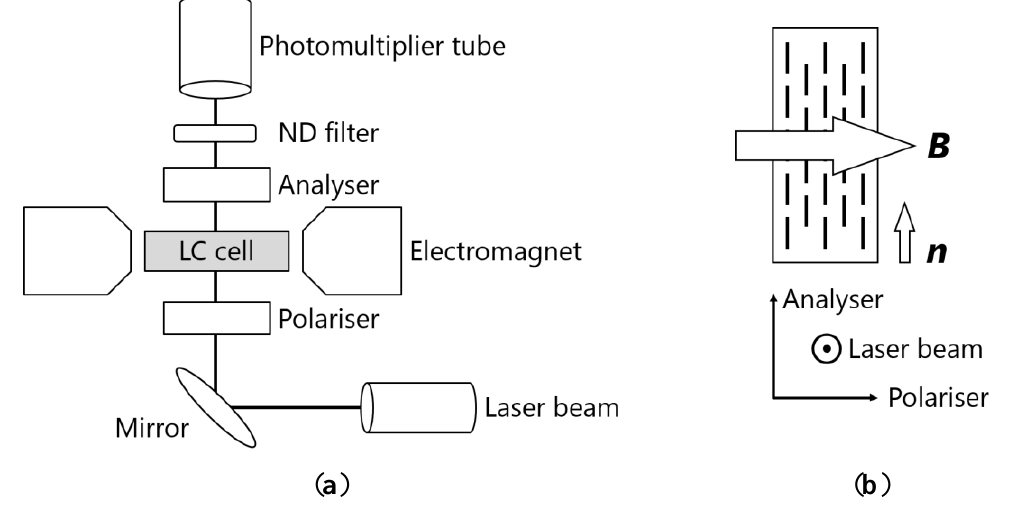
Figure 2. ( a ) Experimental setup for magneto-optical measurements; ( b ) Top view of the liquid crystalline (LC) cell in the initial